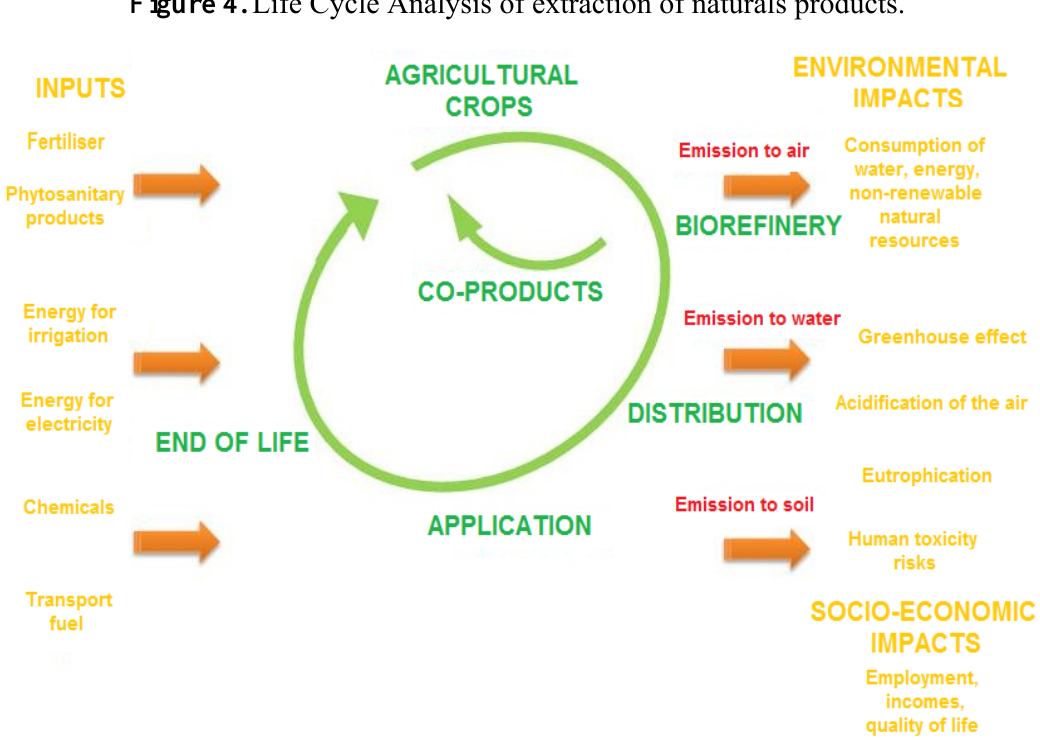
Figure 4. Life Cycle Analysis of extraction of naturals